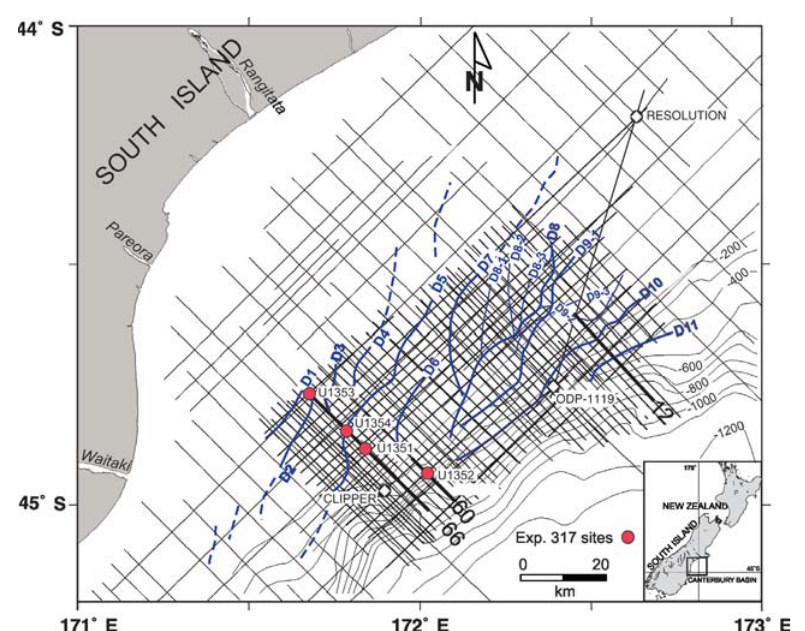
Figure 2. Expedition 317 sites (red), together with EW00-01 high-resolution (frequencies up to 300 Hz) seismic survey grid (dense grid of black straight lines), low-resolution CB-82 commercial seismic profiles (gray straight lines), exploration wells Clipper and Resolution, and ODP Site 1119. The EW00-01 survey was designed to provide improved vertical resolution (~5 m in the upper 1 s) to enhance definition of high-frequency sedimentary sequences. Also shown is the distribution of seismically resolvable sediment drifts (D1 to D11; blue curved lines mark crests of the drift mounds). Dashed blue lines represent drifts identified on CB-82 profiles. Locations of dip profiles shown in Figs. 4, 5, 6 (profiles 12, 66, and 60, respectively) are shown as thicker black lines. Bathymetric contours are in